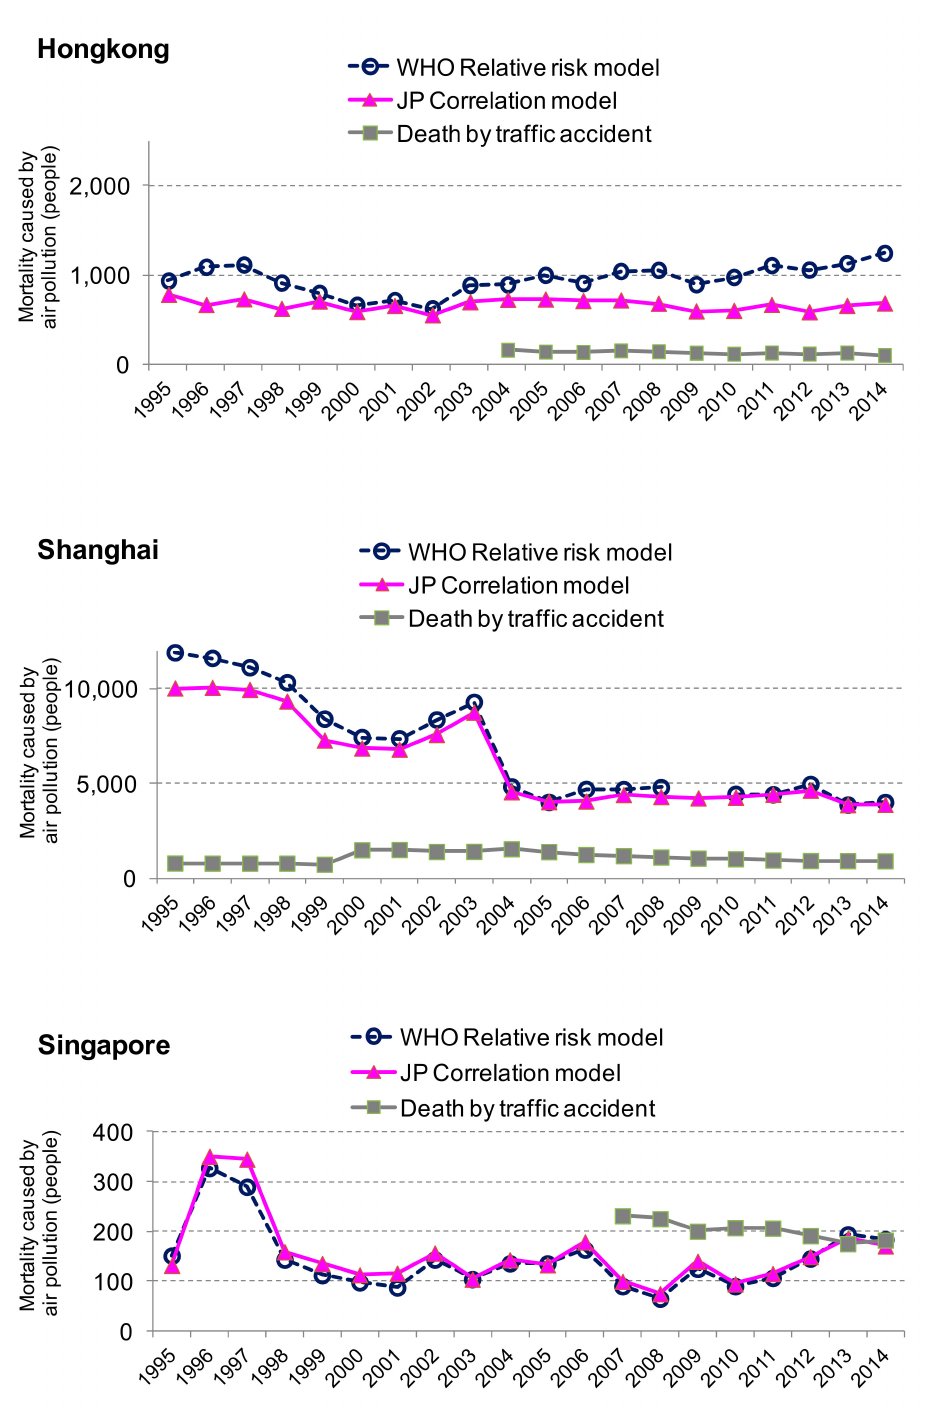
Figure 3. Comparison by city and by time